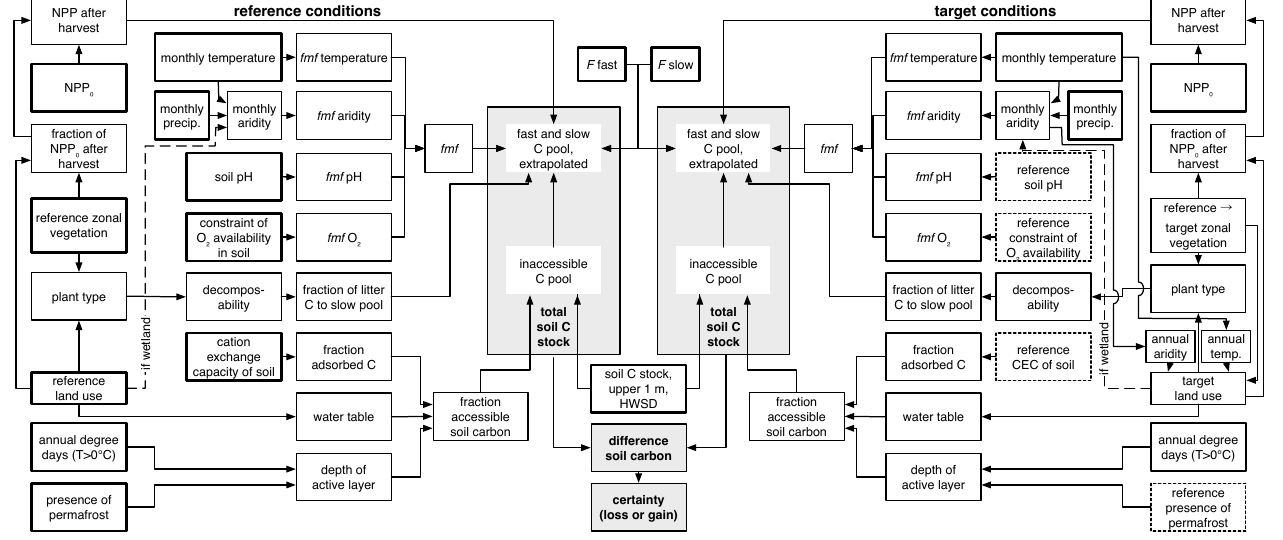
Figure 1. Network design: fmf is the decomposition fraction modifying factor and F is the decomposition fraction. Boxes with thick edges indicate directly supplied information. Boxes with dashed edges (on the target side) indicate values copied from the reference side. Shaded boxes indicate dependent